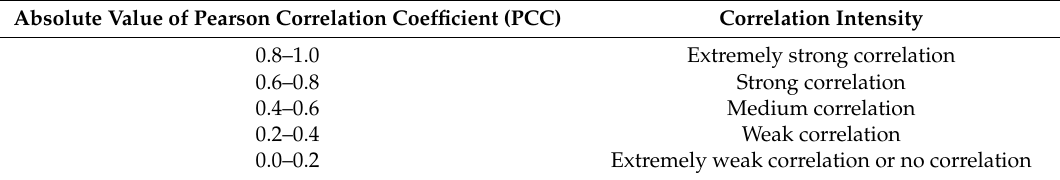
Table 1. Person correlation coefficients and correlation